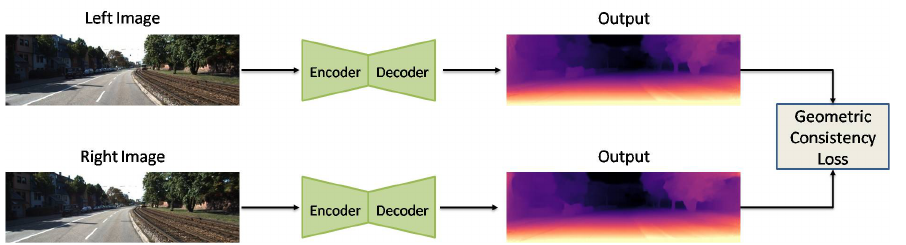
Figure 7. Developed network by Goldman et al. [108].